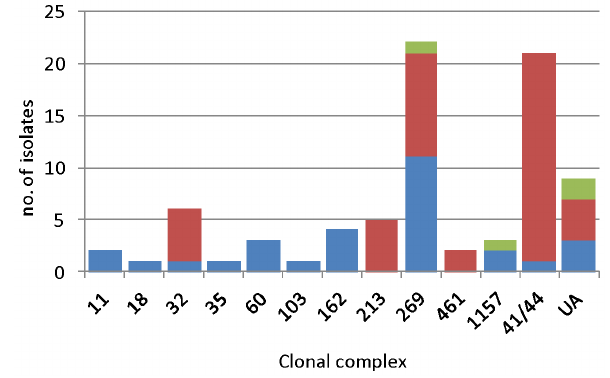
Figure 1. Clonal complex distribution of the combinations of hmbR and hpuA genes among a representative panel of English, Welsh and Northern Irish invasive serogroup B meningococcal isolates collected from 2008–2011. Blue bars indicate hmbR:hpuA , red bars indicate hmbR -only and green bars indicate hpuA -only. UA= unassigned STs.